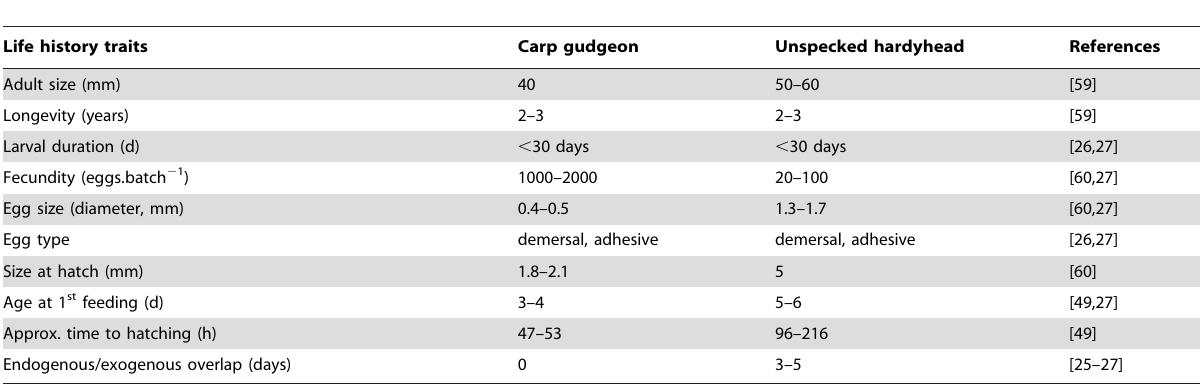
Table 1. Life history traits of carp gudgeon and unspecked hardyhead.